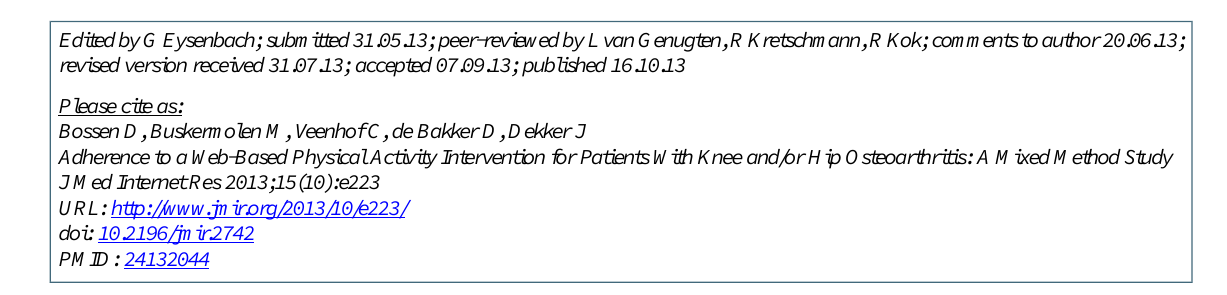
OA: osteoarthritis OR: odds ratio PA: physical activity PASE: PA Scale for the Elderly RCT: randomized controlled trial ROC: Receiver Operating Characteristic